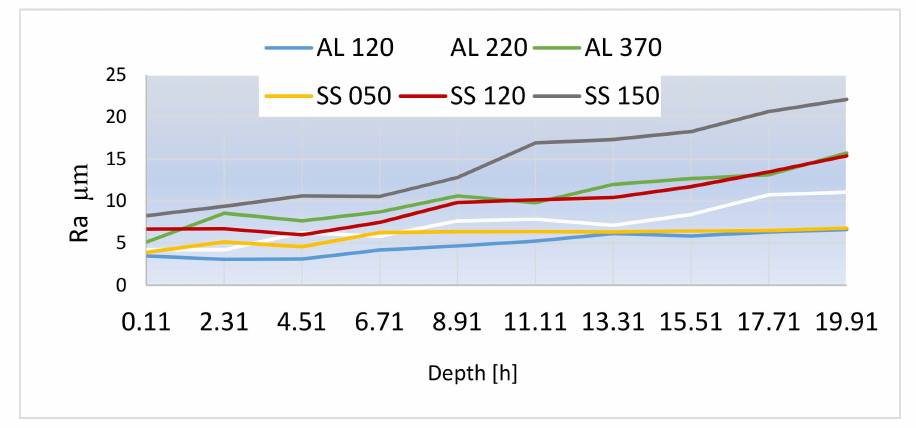
Figure 9. The graphical dependence of Ra on the measurement depth for AL120, AL220, AL370 and SS050, SS120, SS150.